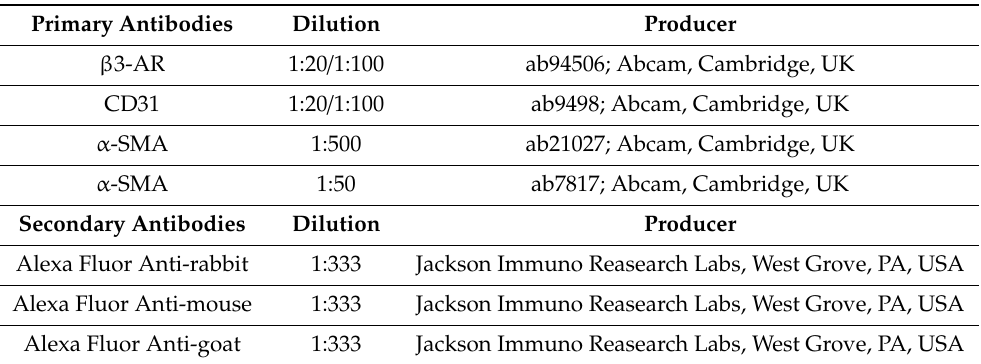
Table 1. List of primary and secondary